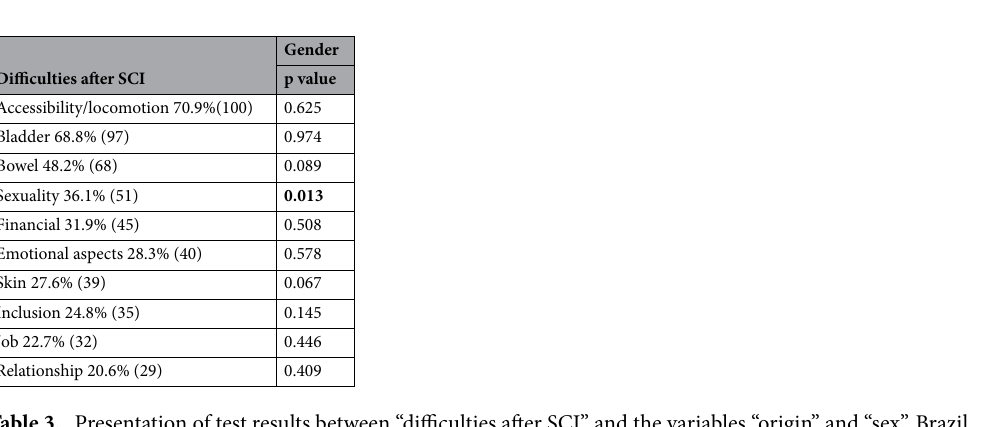
Table 3. Presentation of test results between “difficulties after SCI” and the variables “origin” and “sex”, Brazil, 2018. *Pearson’s Chi-Square Test. Significant values are in [bold].